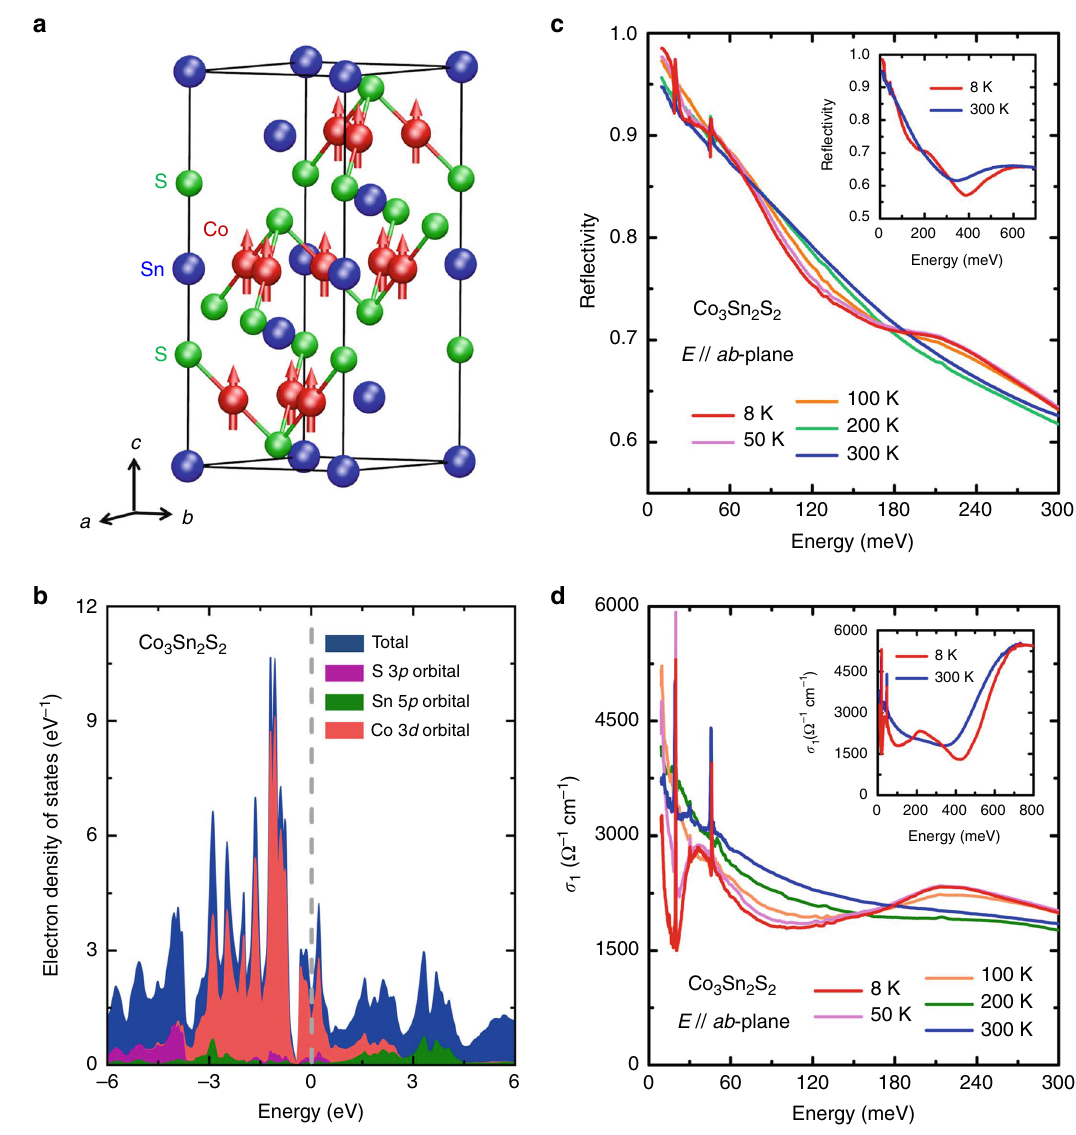
Fig. 1 ab -plane optical response of Co 3 Sn 2 S 2 . a Crystal structure of Co 3 Sn 2 S 2 . A quasi-two-dimensional Co 3 Sn layer is sandwiched between the sulfur atoms. The magnetic moments on the cobalt sites are along the c -axis. b Electron density of states (DOS) obtained by single-particle ab initio calculations in the FM ground state. The electron DOS near the Fermi energy is mainly contributed by the electronic bands with Co 3 d orbital characters. c Several representative re fl ectance spectra R ( ω ) measured with the electric fi eld ( E ) of the incident light parallel to the crystalline ab -plane. The inset shows that the R ( ω ) up to 700 meV. d Real parts σ ω ) of the ab -plane optical conductivity at different temperatures. The inset displays the σ 1 (